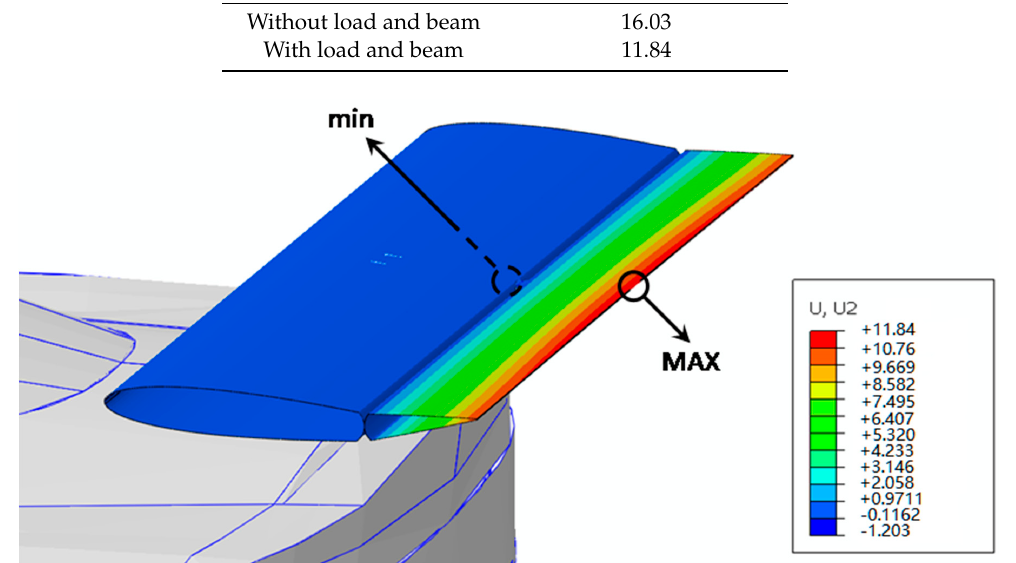
Figure 9. Case study #1: actuated structure. (unit: mm).